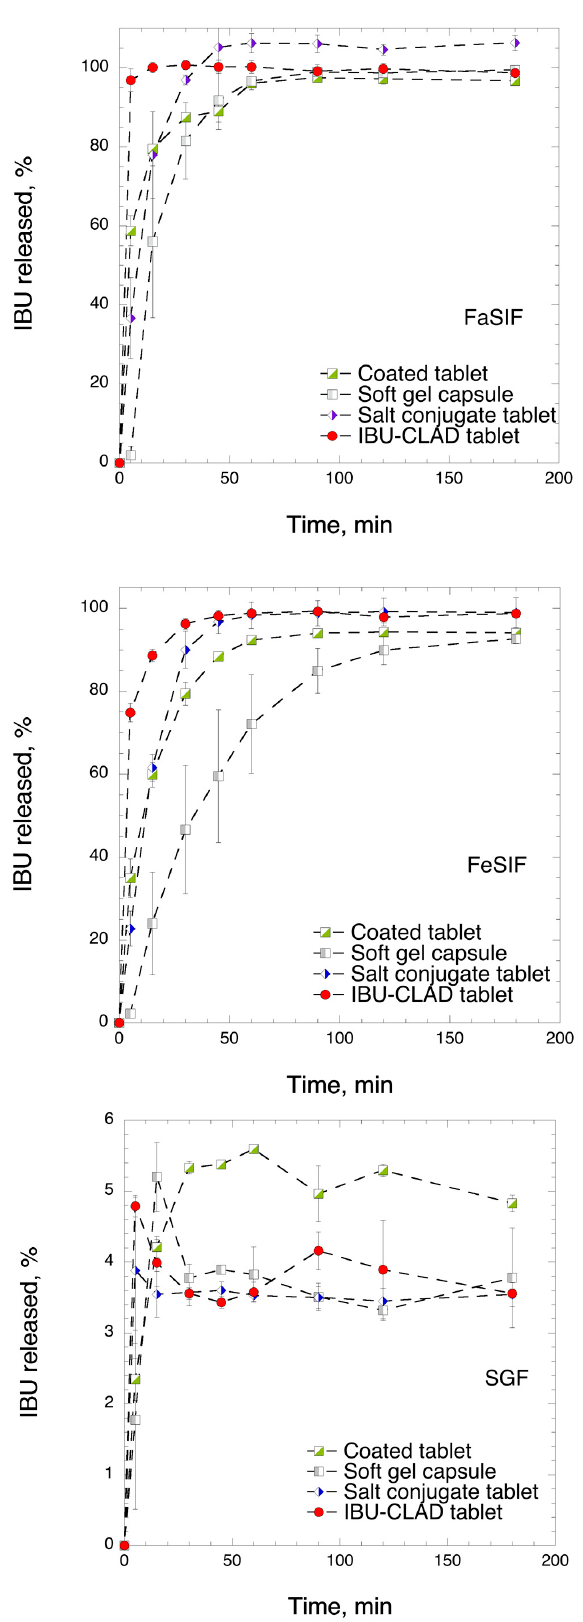
Figure 6. In vitro dissolution profiles of studied formulations in FaSIF, FeSIF, and SGF media. The results are the average of three measurements with standard deviation as error bars.